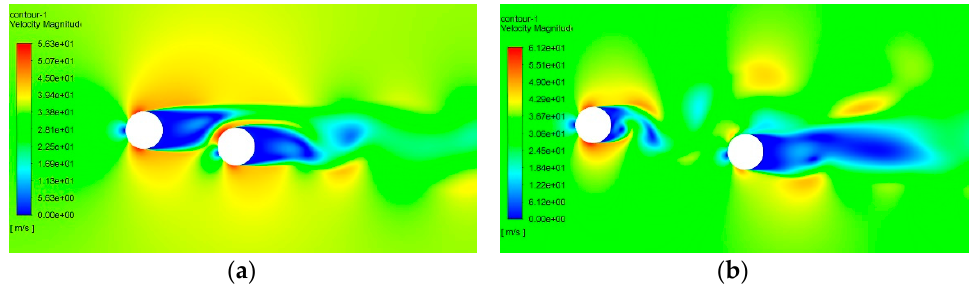
Figure 13. Velocity contours for twin cylinders arranged in staggered ( α = 10°): ( a ) W/D = 2.5; ( b ) W/D = 4.3.